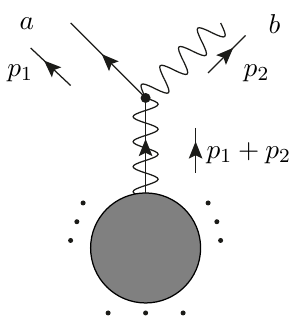
Figure 14 . Feynman diagrams leading to collinear gaugino and gauge boson